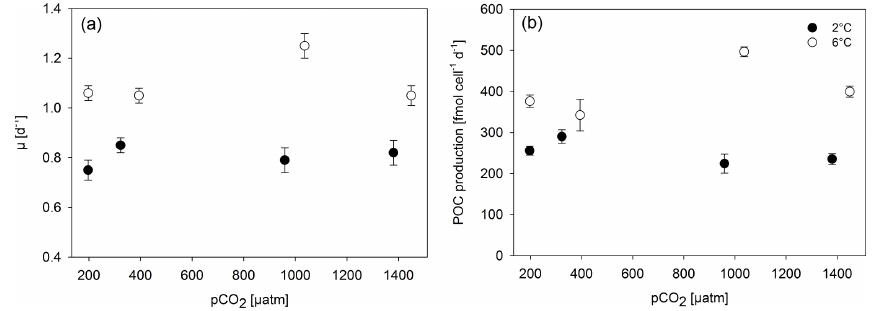
Figure 1. Specific growth rate constant µ (a) and POC production (b) of M. pusilla under low (filled symbols) and high (open symbols) temperatures as a function of p CO 2 ( n = 3; mean ± 1SD). Results from statistical analysis can be found in Table S2.